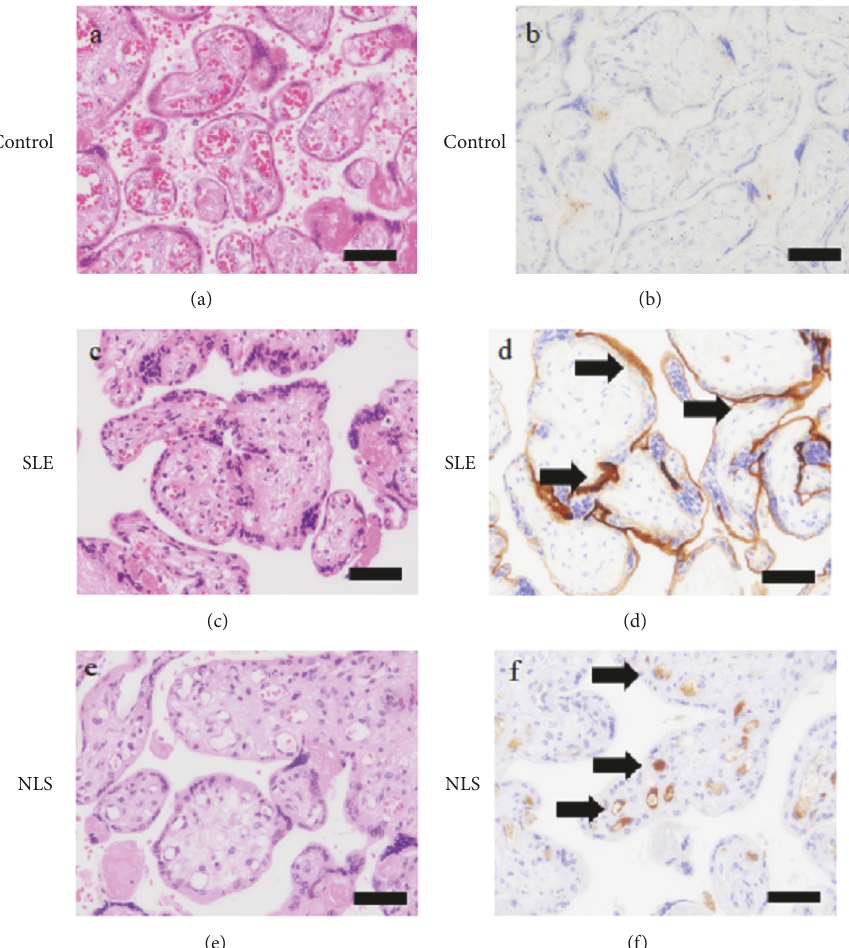
Figure 2: Histological findings from placentas obtained from the control pregnancy (28-year-old mother at 35 weeks of gestation, (a, b)), systemic lupus erythematous (SLE) pregnancy (40-year-old mother at 30 weeks of gestation, (c, d)), and neonatal lupus syndrome pregnancy (31-year-old mother at 35 weeks of gestation, (e, f)). (a, c, e) Representative images of tissue sections stained with hematoxylinand eosin (HE). (b, d, f) Representative anti-C4d immunostaining images (arrows). Scale bar = 50 𝜇